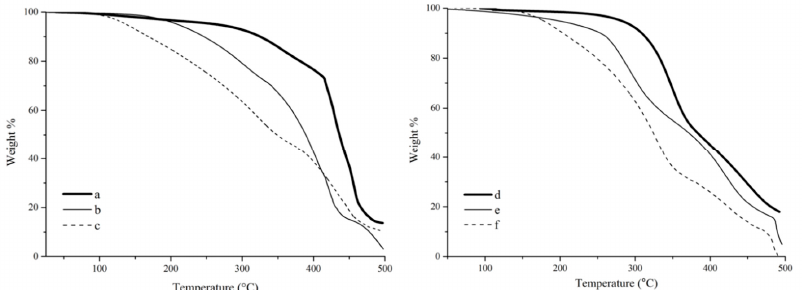
Figure 8. TGA curves of ( a ) tung oil resin, ( b ) tung oil fatty acid resin, ( c ) tung oil methyl ester resin, ( d ) composite prepared with tung oil resin, ( e ) composite prepared with tung oil fatty acid resin, and ( f ) composite prepared with tung oil methyl ester resin.